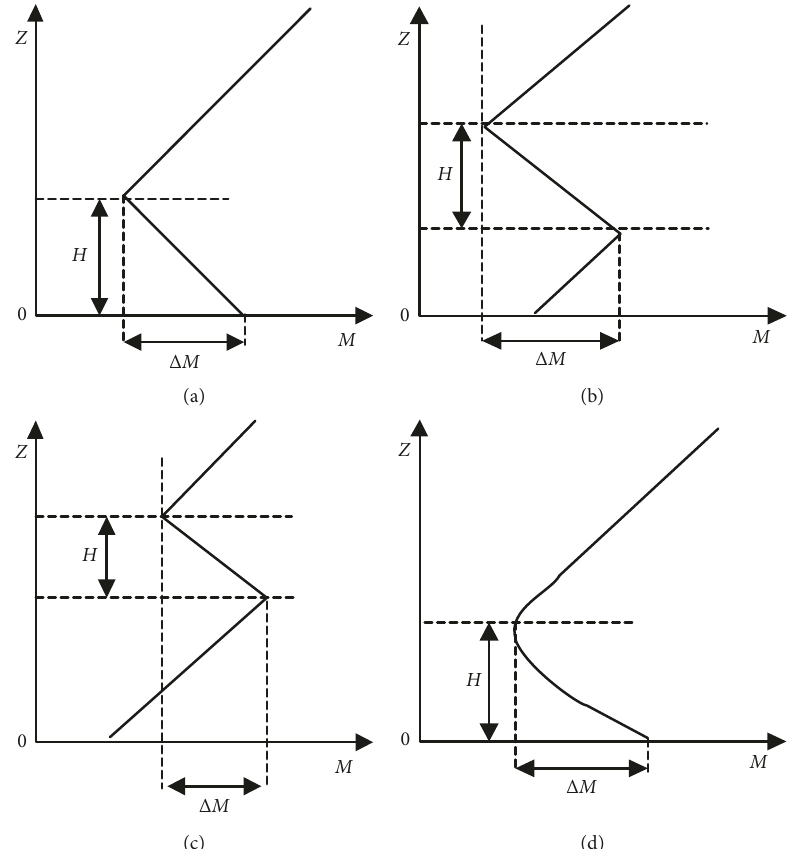
Figure 2: Classification of atmospheric ducts: (a, b) surface duct; (c) elevation duct; (d) evaporation